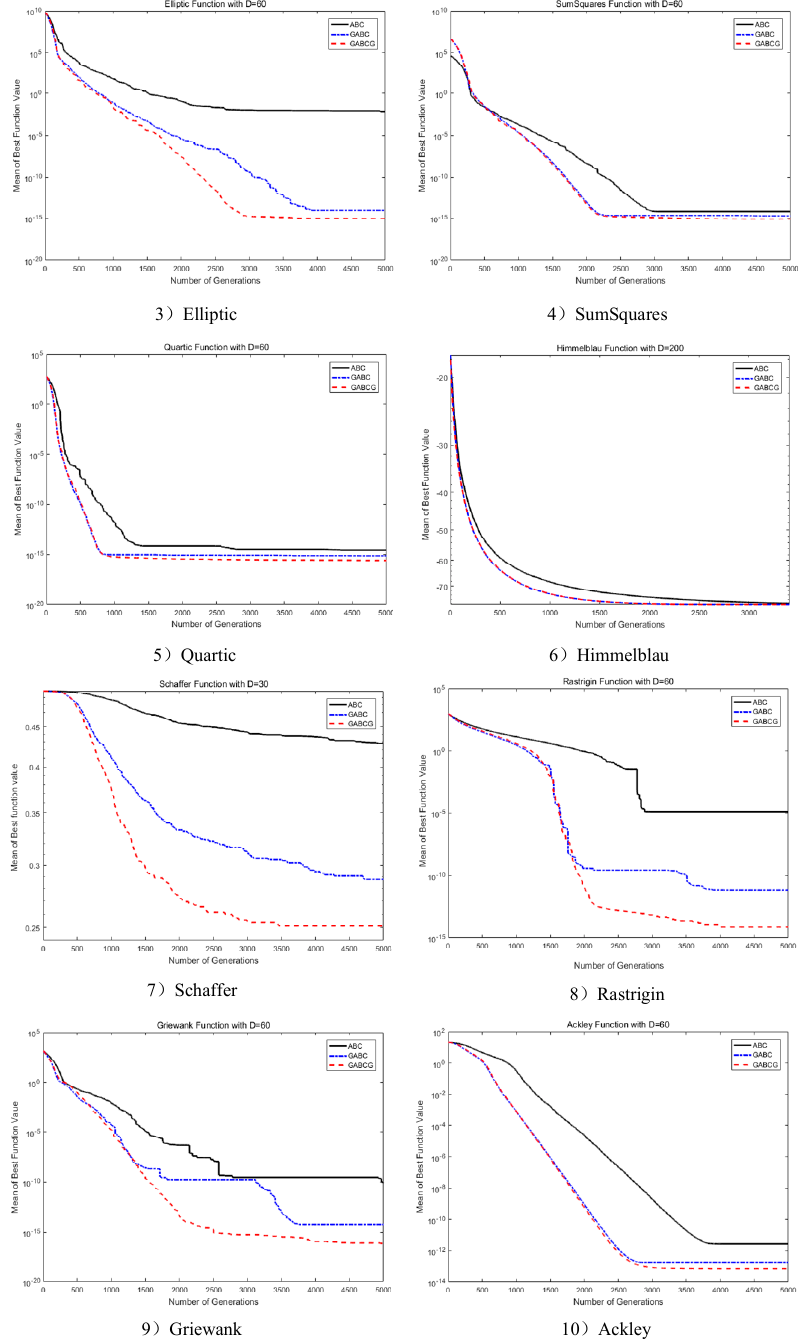
Figure 3. Convergence curves of the ABC, GABC, and GABCG algorithms for benchmark functions.